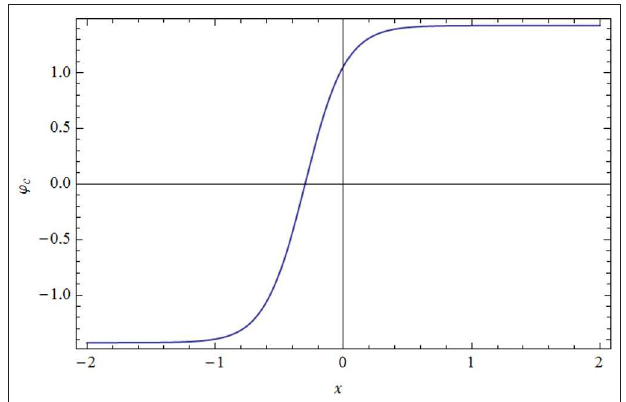
0.01, v 0.01, L 0.95. = = =